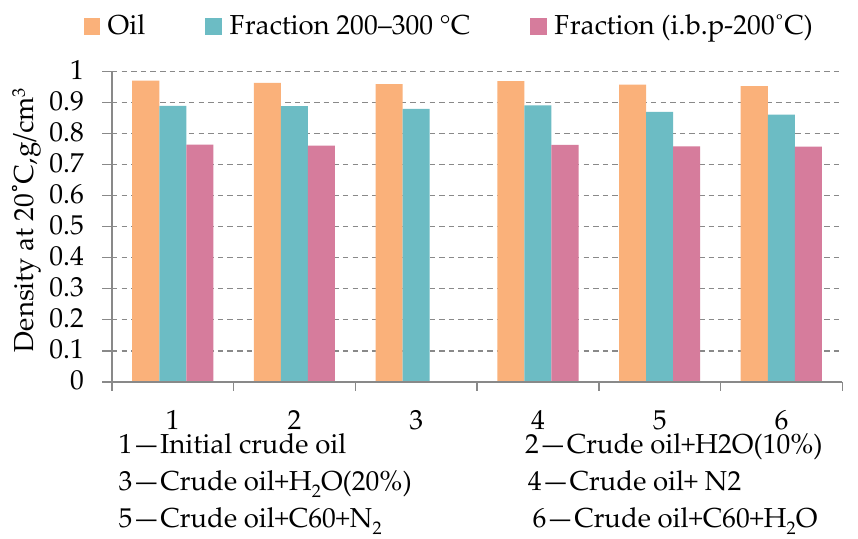
Figure 4. The density of crude oil and light distillates before and after catalytic thermolysis measured at 20˚C.